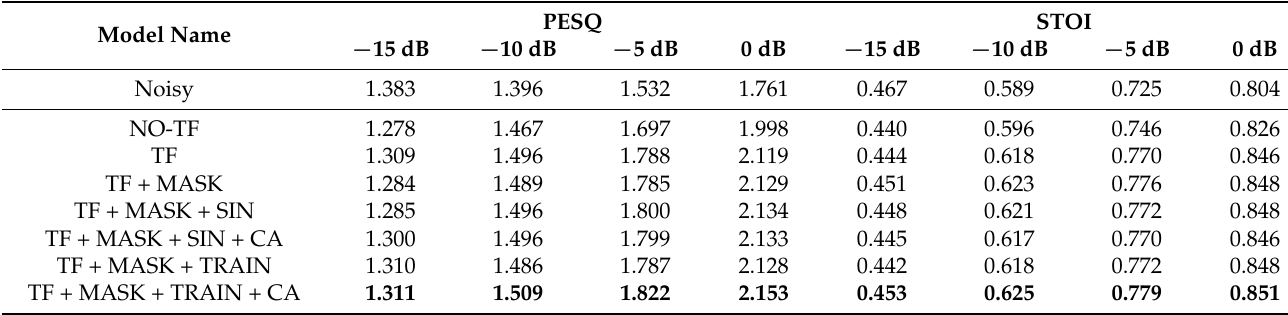
Table 8. Ablation experiments in the Babble test